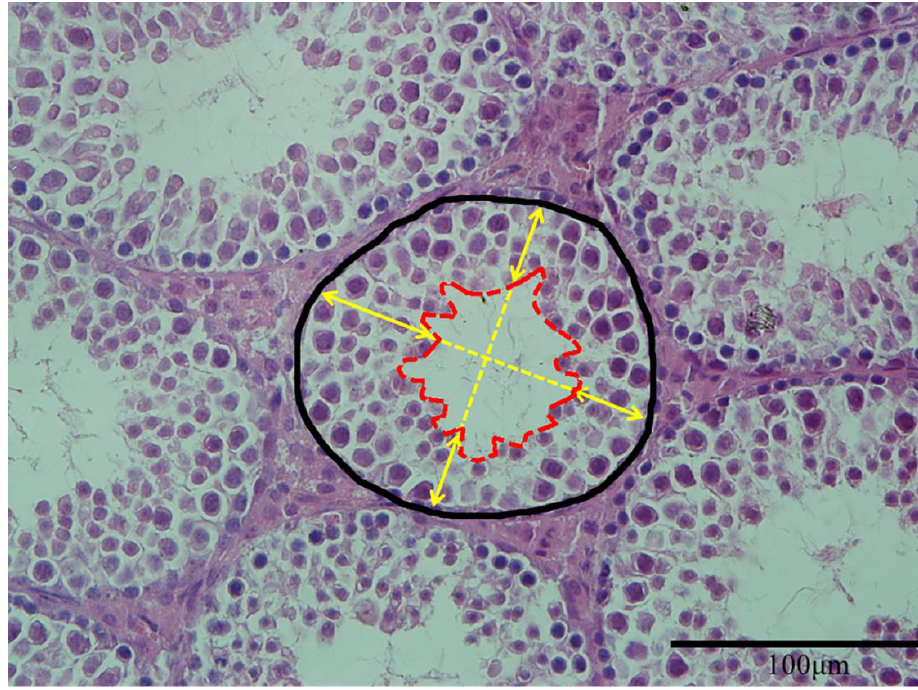
Figure 1. Measurement of seminiferous tubules components. The area in black line defines the cross-sectional area of a seminiferous tubule. The area in red line defines the area of lumen. The average length of the four yellow arrows represented the height of seminiferous epithelium (magnification: ×400).